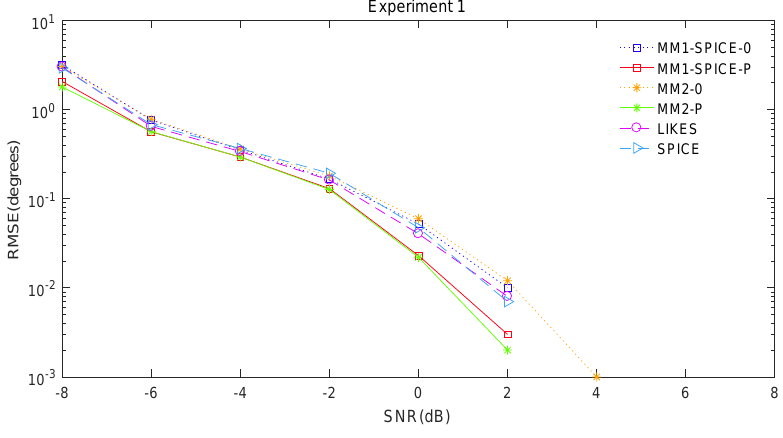
Figure 1. DOA estimation RMSE versus SNR for Experiment 1.